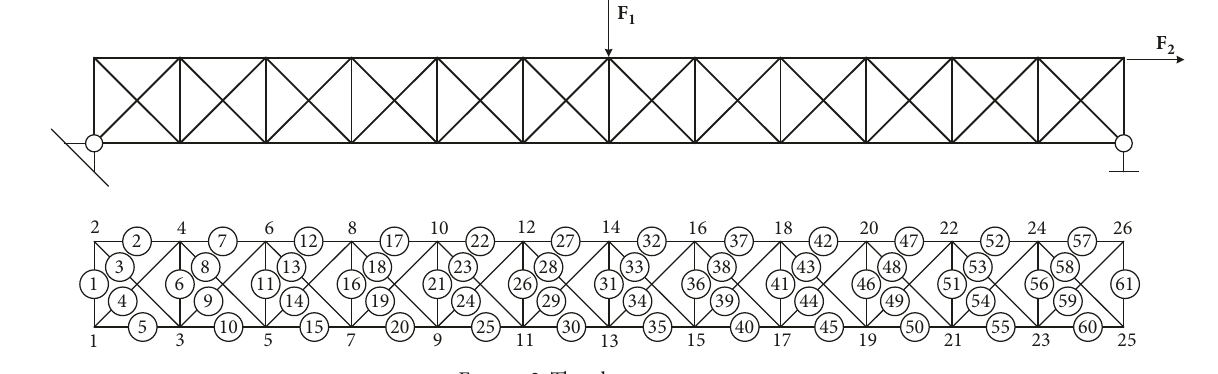
Figure 2: The plane truss structure. Table 2: Identification results from single principal component without measurement noise effect.